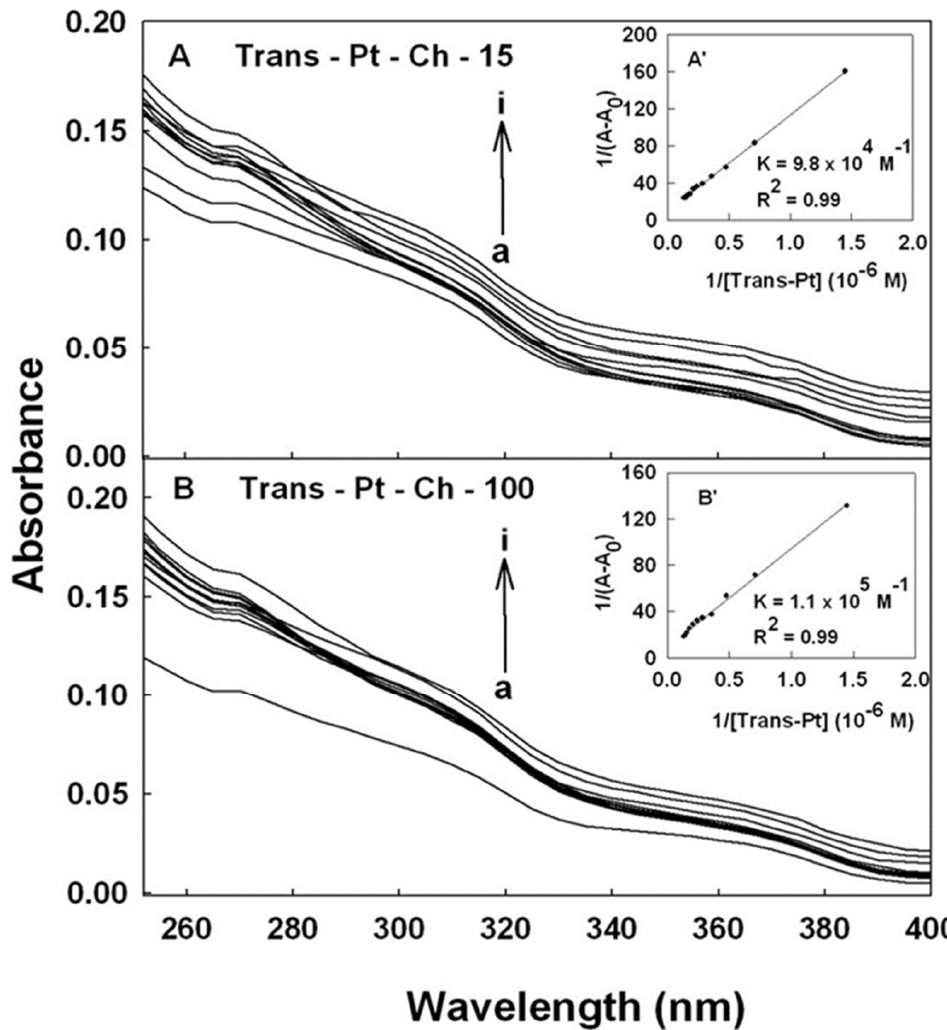
Figure 2. UV–visible spectra of chitosan nanoparticles with trans–Pt with free chitosan at 60 µ M (a) and trans–Pt at 1, 5, 10, 20, 30, 40, 60, and 80 µ M (b–i). Inset: plot of 1/(A 0 − A) vs. (1/drug concentration) and binding constant ( K ) for trans–Pt–polymer complexes. ( A ) Trans–Pt–Ch–15, ( B ) Trans - Pt - Ch - 100.